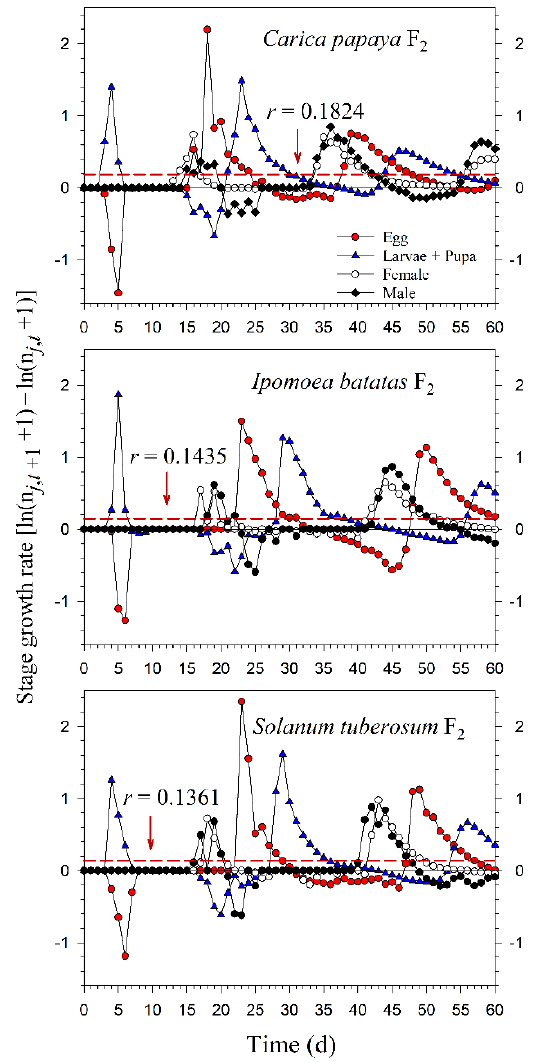
Figure 8. Fluctuations in the growth rates of each life stage of Paracoccus marginatus individuals reared on three different host plants (F 2 ). The red vertical dashed lines in each figure denote the intrinsic rate of increase ( r ).